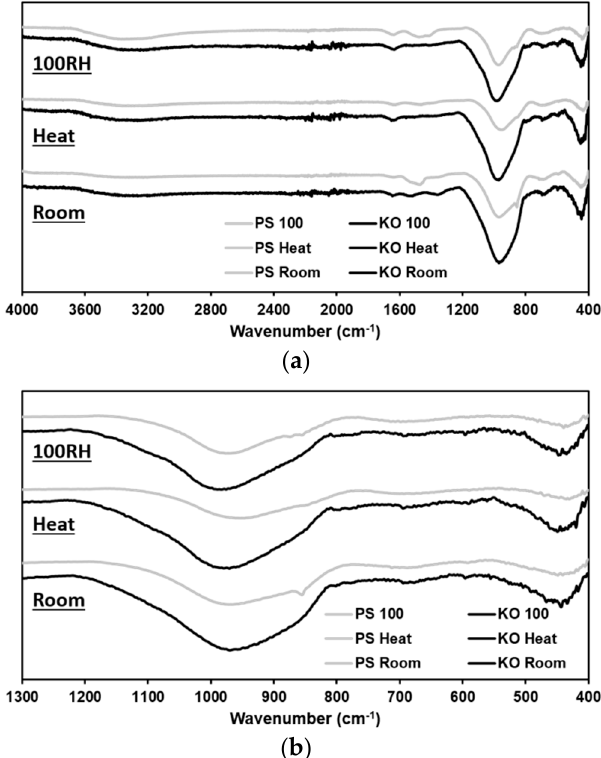
Figure 5. FTIR spectra of IP pastes cured under different conditions. ( a ) Full spectra collected; ( b ) close-up of low wavenumber region.